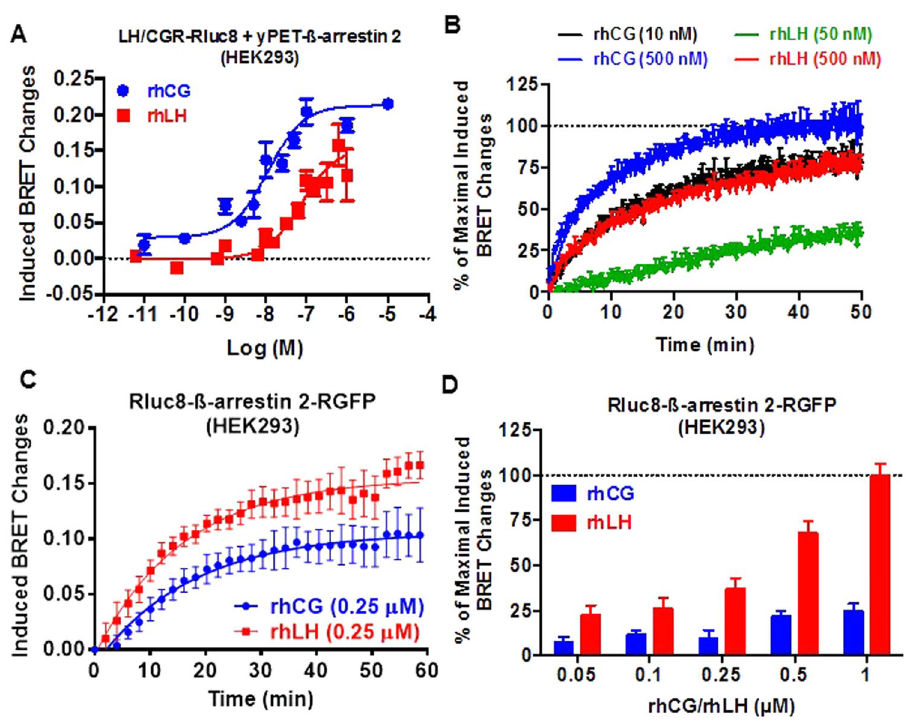
Figure 2. LH/CGR-promoted β -arrestin 2 recruitment and activation in HEK293 cells. HEK293 cells transiently co-expressing either hLH/CGR-Rluc8 and yPET- β -arrestin 2 ( A and B ) or wildtype hLHR/CGR and Rluc8- β -arrestin 2-RGFP ( C ) were stimulated 30 minutes with increasing doses ( A and D ) or immediately with the indicated doses ( B ) or 0.25 µ M ( C ) of rhCG and rhLH before BRET was measured. Data are means ± SEM of 3–5 independent experiments. The kinetic curves in panel B are representative of 3 experiments performed in